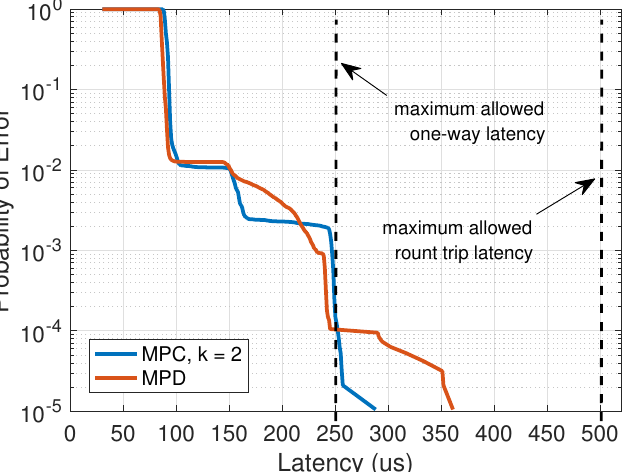
Figure 8. Probability of error vs latency function for multi-path fronthaul with erasure coding (MPC) with k = 2 and multi-path fronthaul with duplication (MPD). The dashed line represents the maximum latency to be supported by the MAC–PHY split